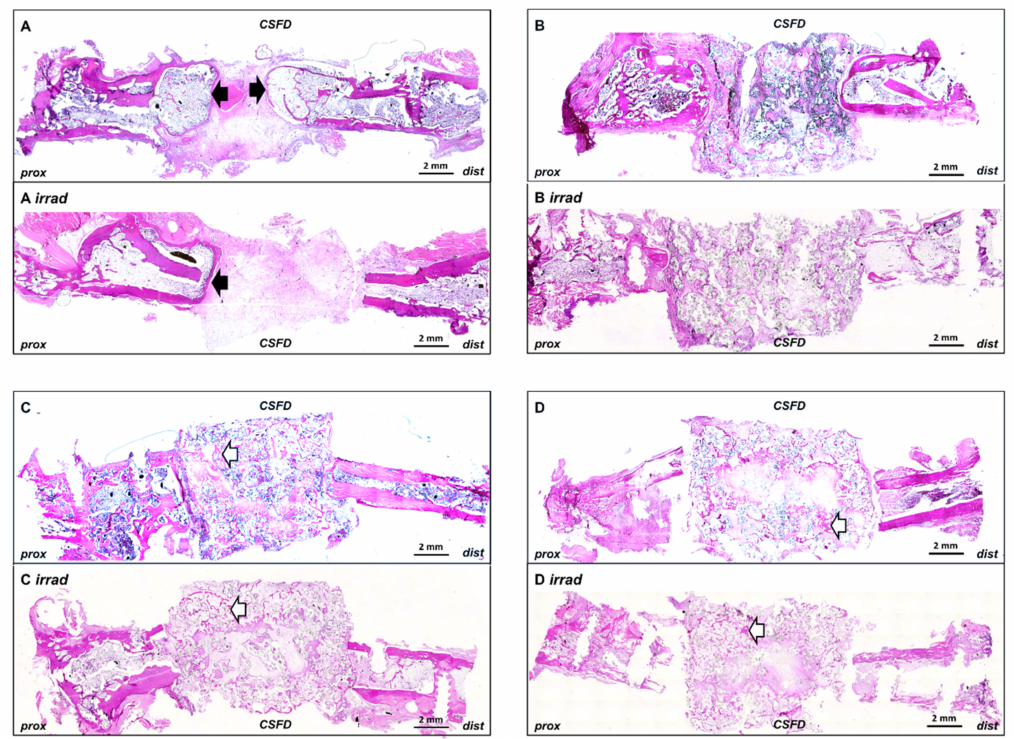
Figure 3. Bone formation in implanted constructs. The newly formed bone tissue was clearly visible in group C/C irrad and D/D irrad (white arrows), whereas no bone formation was induced by the scaffold alone (B/B irrad). Outgrowth of bone tissue from the femoral stumps was present in group A but very limited in group A irrad (black arrows). (( A – C ): 12 weeks after CSFD, ( D ): 10 days after CSFD). Scale bar 2 mm. Merged images. Total magnification × 40.